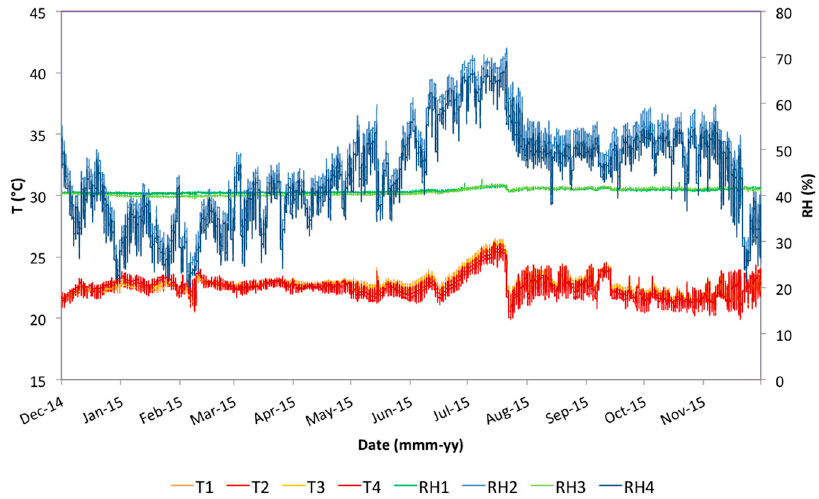
Figure 2. Temperature (T) and relative humidity (RH) values collected by the probes during a year of monitoring, from 1 December 2014 to 30 November 2015 (probes 1 and 2 representing the environment inside and outside of the microclimatic frames of Painting A and probes 3 and 4 representing the same for Painting B ).